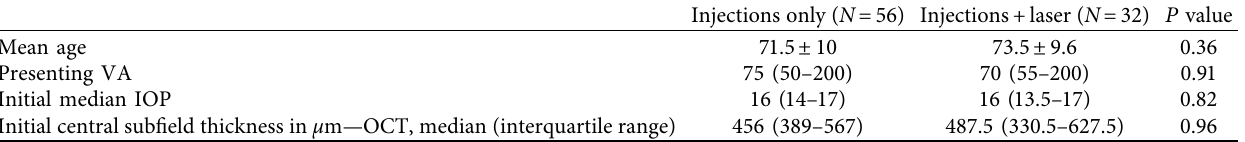
Table 1: Demographics in BRVO-related ME: injections only vs. injections plus focal laser.